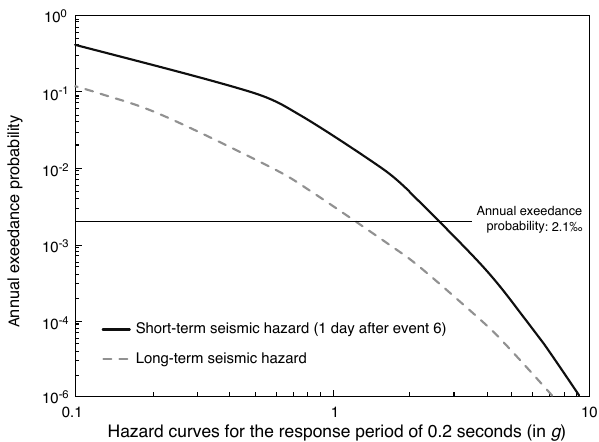
Fig. 8. The probability of annual exceedance as a function of haz- ard curves for the response period of 0.2 seconds at two moments. The gray dashed line represents the long-term hazard curve (i.e., the short-term rate perturbation was not considered). The black solid line represents the hazard curve one day after the 2007 M L = 5.8 earthquake (event 6 in Table